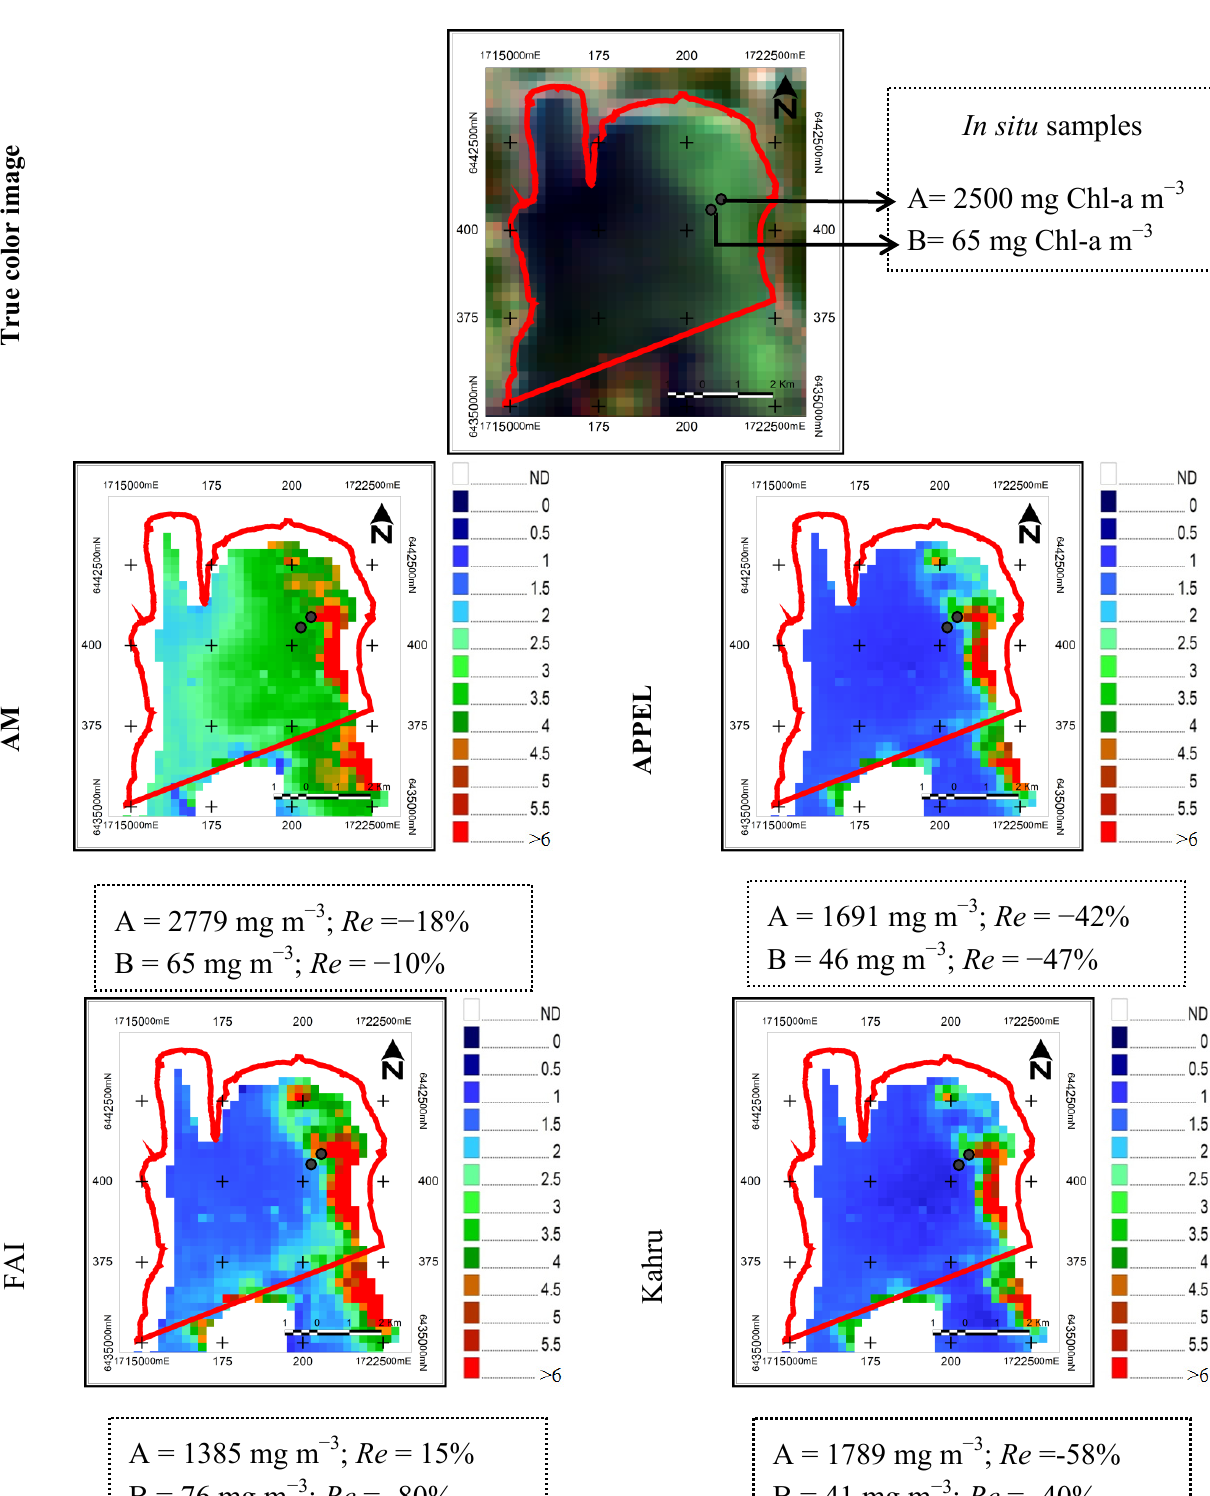
Figure 12. Comparison between estimated chlorophyll-a concentration calculated by the AM, APPEL , FAI , and Kahru models and in situ measurements obtained by the MDDELCC at two stations on Missisquoi Bay on Lake Champlain on 19 September 2001. Chlorophyll-a concentrations are on a Napierian logarithmic